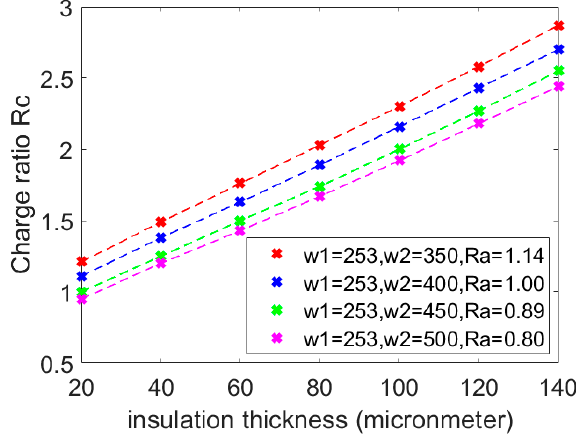
Figure 4. XS anode simulation model established by COMSOL.